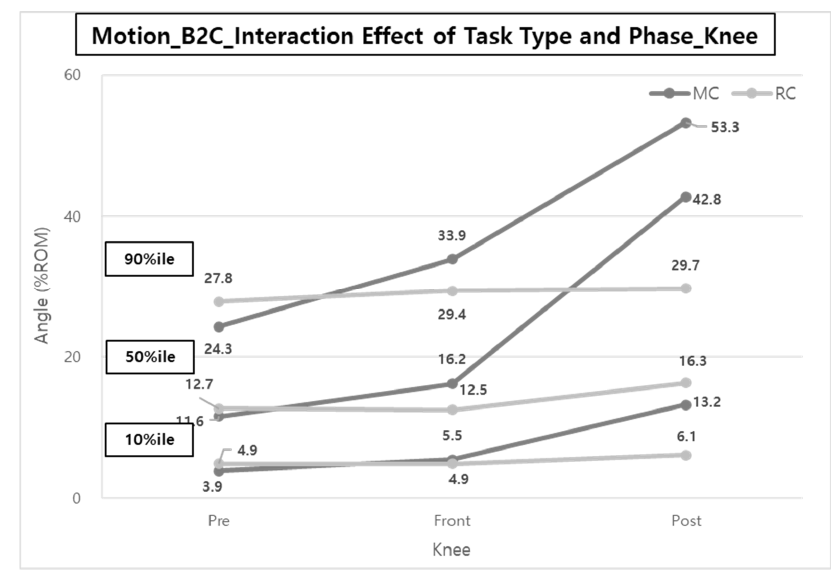
Figure 14. Interaction effect of task type and phase on the ROM of Knee (B2C).